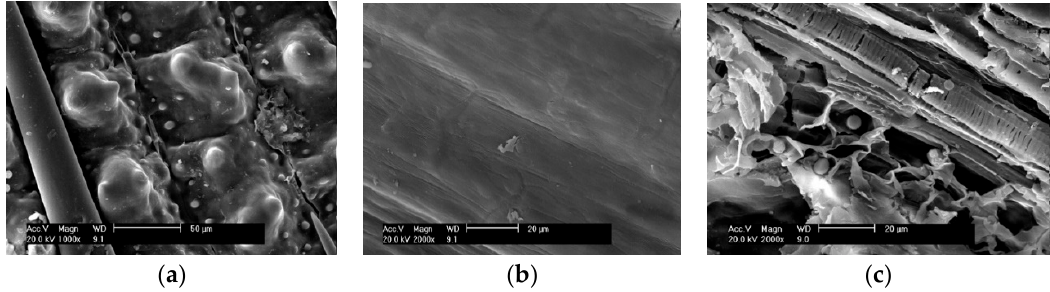
Figure 5. SEM morphologies of ( a ) outside surface; ( b ) inside surface and ( c ) interlayer of the water-leached RH.